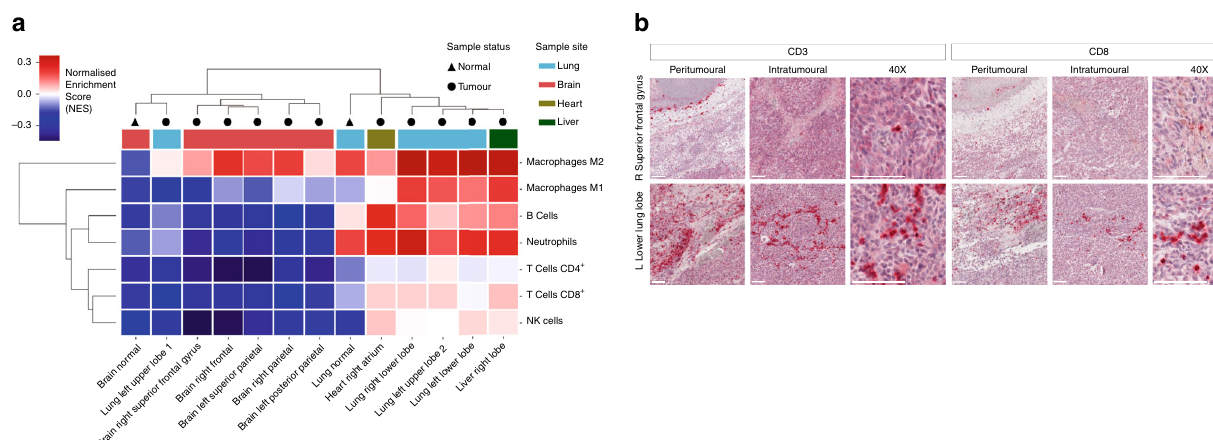
Fig. 5 Regional differences in immune cell representation; brain vs. lung metastases. a Immune cell deconvolution of mRNA using hierarchical clustering of Consensus TME scores 66 . Scale indicates high-low normalised enrichment scores (red-blue). Both the brain normal and metastases were relatively immuno-privileged when compared to lung normal and lung metastases (note that one of the four lung metastases, left upper lobe 1, was an outlier clustering with the immune-sheltered brain samples). b Immunohistochemical (IHC) validation against CD3 and CD8 in a representative brain and lung metastasis. One representative region from each tumour sample is shown. Chromogen red indicates positive immune cell staining. The thick white line represents 100 µ m in 10-fold (peritumoural and intratumoural) and 40-fold magni fi cation,